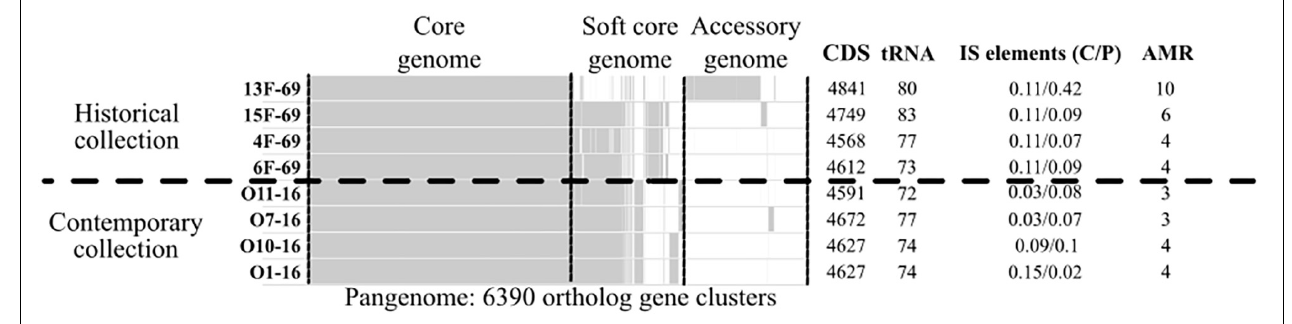
FIGURE 2 | Nullarbor report of the pangenome of the eight Serratia marcescens studied strains, including as additional data the frequency of completely (C) or partially (P) present insertion sequences (ISs), and the number of antimicrobial resistance genes (AMR). Core genome is constituted by genes present in > 99% of strains. Soft core genome is constituted by genes present in 99-15% of strains. Accessory genome is constituted by genes present in < 15% of strains. CDS, protein-coding